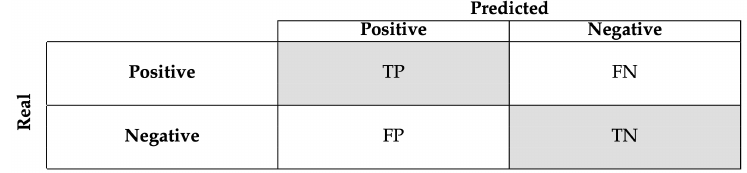
Figure 8. Example of confusion matrix for binary